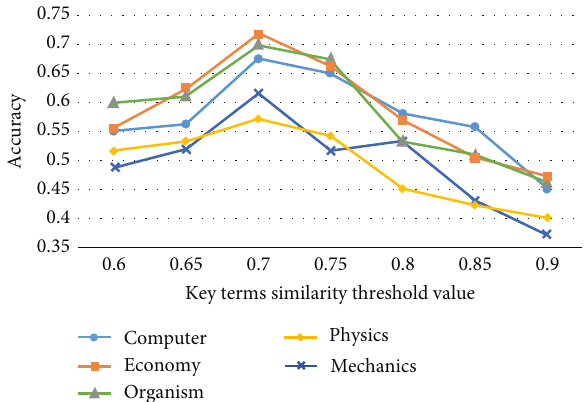
Figure 8: Accuracy comparison of various key similarity threshold value.